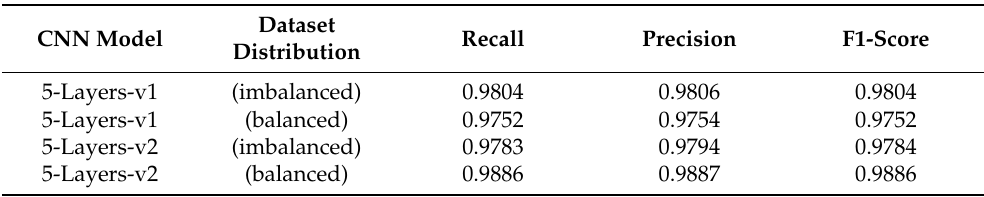
Table 13. Performance of 5-layer CNN models trained on the original dataset; (Comparison based on Class Balanced and Imbalanced Dataset).